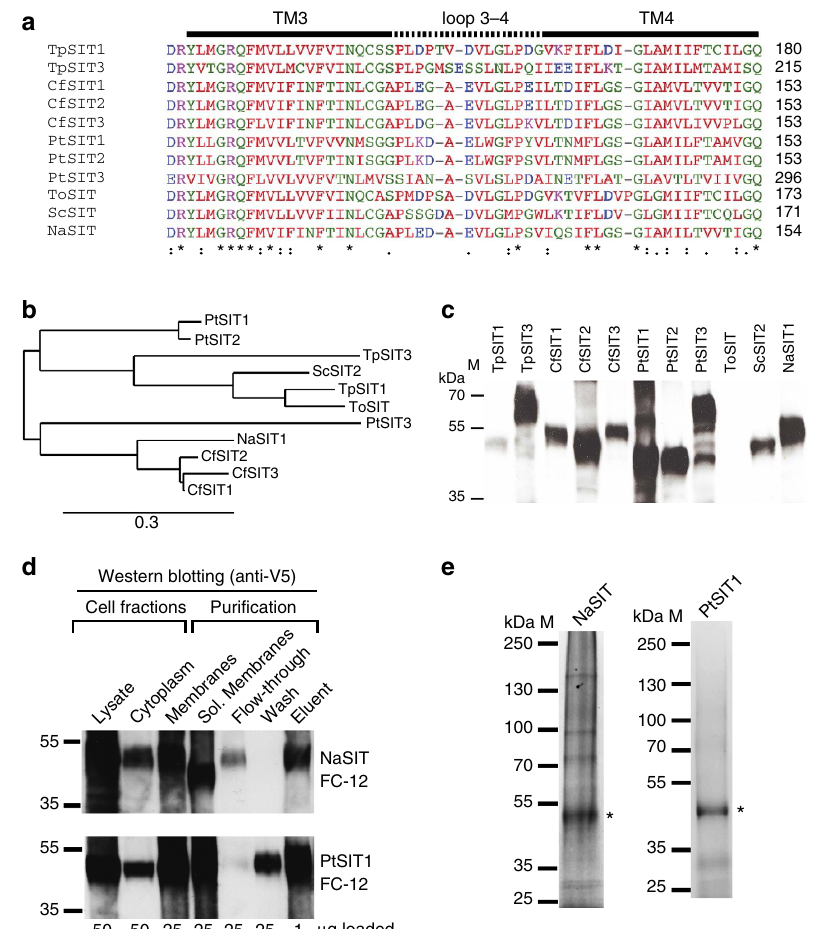
Figure 1 | Recombinant expression of silicon transporter homologues in S. cerevisiae . ( a ) Representative part of a multiple sequence alignment of SIT homologues, exemplifying the results of the alignment and showing conserved transmembrane (TM) regions connected by divergent extramembrane loops. Symbols denote (*) conserved, (:) strongly similar and (.) weakly similar residues at each position. ( b ) Phylogenetic tree showing evolutionary relationships between homologues. ( c ) Qualitative western blot showing the relative expression levels of recombinant SITs in S. cerevisiae . Each lane contains 50 m g total protein. ( d ) Qualitative western blot tracking the fate of selected SITs during cell fractionation and affinity purification. The uncropped blot for PtSIT1 is shown in Supplementary Fig. 5. ( e ) SDS–PAGE of purified SITs stained with Coomassie Brilliant Blue. Bands corresponding to purified SITs are marked